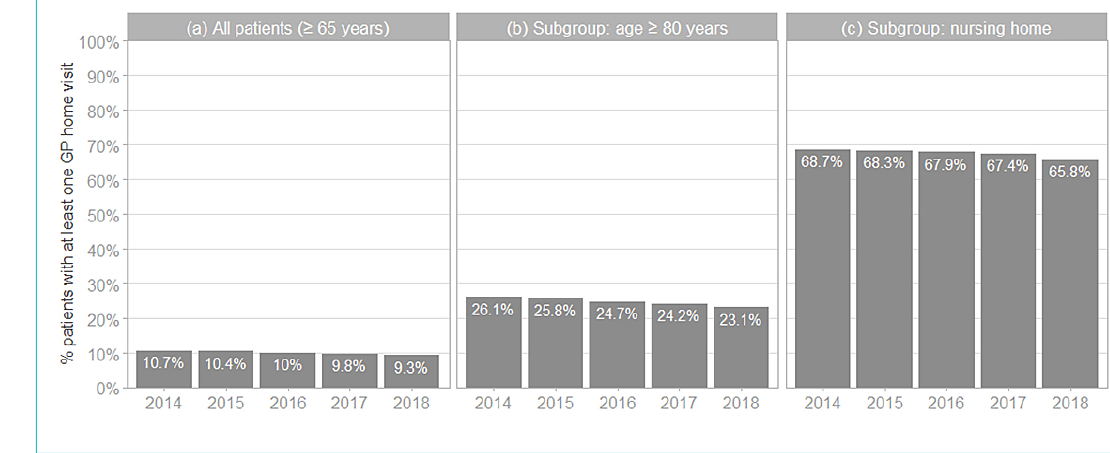
Figure 1: The proportion (%) of patients with at least one GP home visit relative to the total number of patients per year. (a) Overall patients (aged ≥65 years). (b) Subgroup including only patients aged ≥80 years. (c) Subgroup including only patients with a stay at a nursing home in the same year. A significant decrease in GP home visit rates was been observed in all patient groups (p <0.001, controlled for age and sex) (table